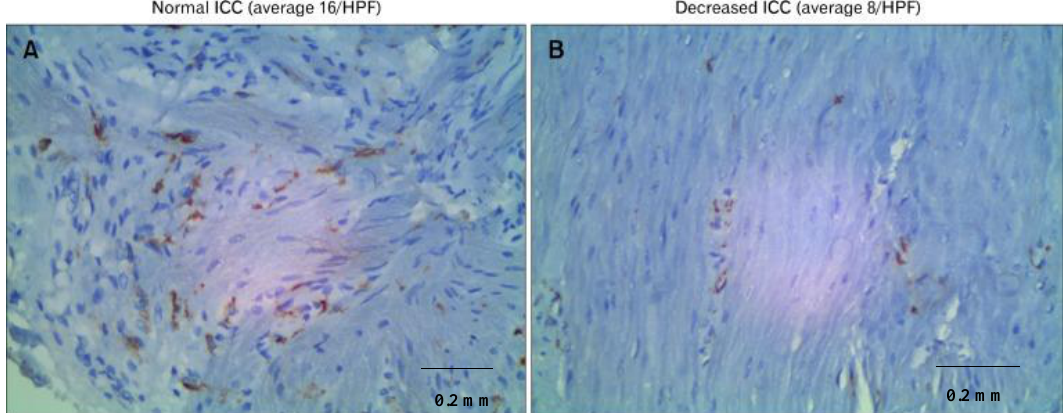
Figure 1. Antral muscularis propria immunostained with c-Kit primary antibody in a non-gastroparetic ( A ) and a gastroparetic patient ( B ). The images were taken at 40× magnification of formalin preserved full-thickness 1 cm 2 surgically obtained gastric biopsies. Interstitial cells of Cajal (ICC) are spindle-shaped brown elements on the image. ( A ) Normal numbers of ICC which is 20 ± 10 (mean ± 2SD) cells per high powered field (HPF). ( B ) Depleted numbers of ICC (less than 10 cells/HPF). The scale line represents 0.2 mm.